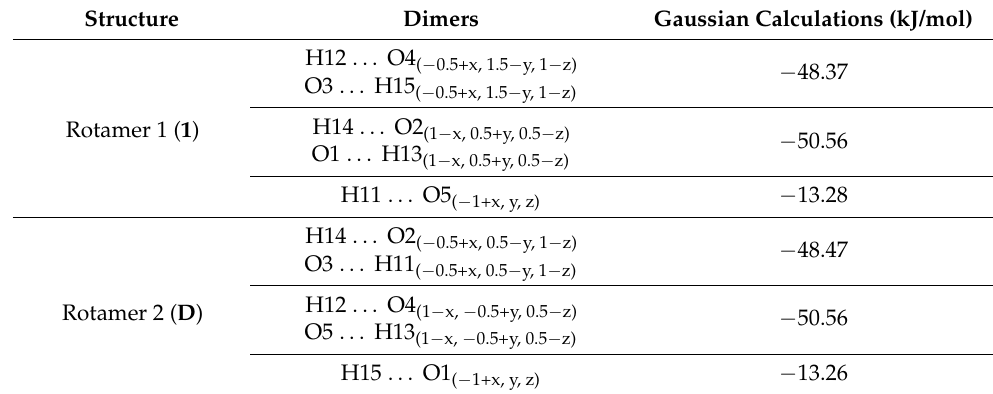
Table 1. Dimer energy calculations using M06-2X/cc-pVDZ for xylitol rotamers 1 and 2 by counter- poise method in Gaussian09. Symmetry operations are given in brackets.